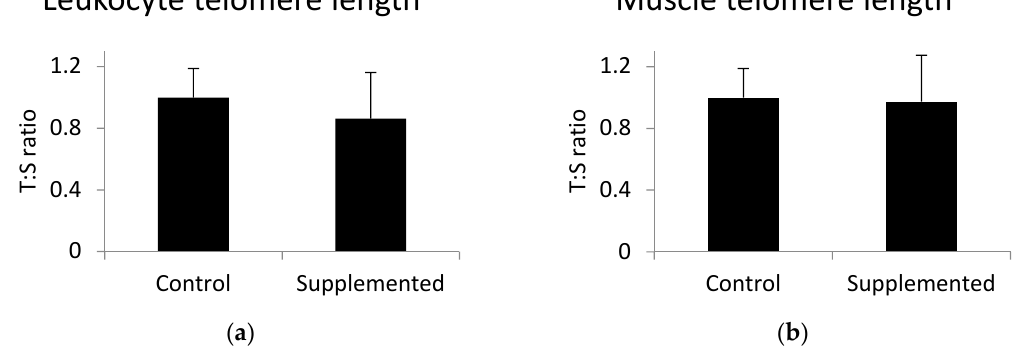
Figure 1. ( a ) Leukocyte and ( b ) gluteus medius muscle telomere length determined using Cawthon’s method. T:S is the ratio of telomere repeat copy number to a single gene copy number. Values are the mean +/ − standard deviation. Statistical differences were analyzed by unpaired t -test.